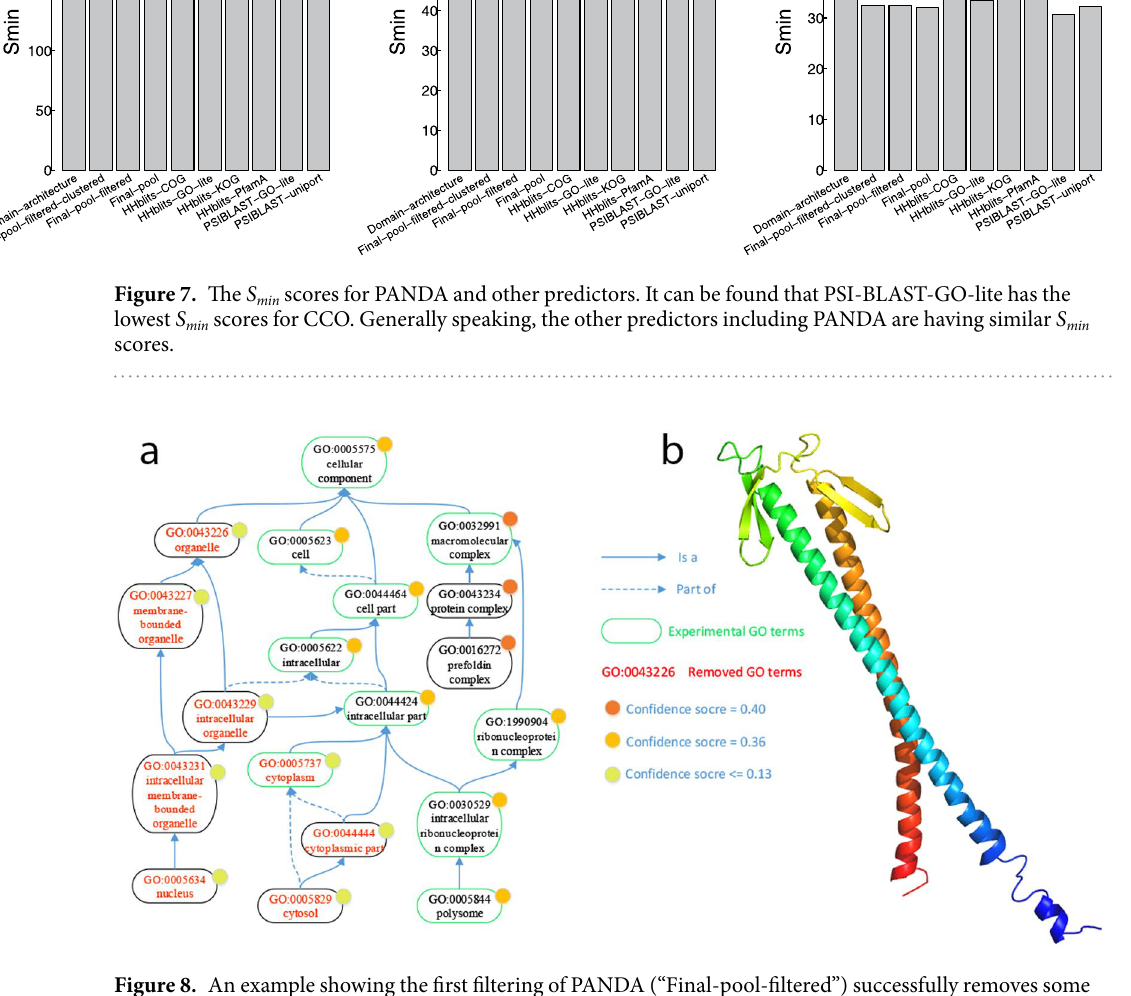
Figure 8. An example showing the first filtering of PANDA (“Final-pool-filtered”) successfully removes some low confidence wrong GO terms from pooled GO terms (“Final-pool”). ( a ) The GO directed acyclic graph showing the GO terms pooled from baseline predictors (all nodes), the GO terms with experimental evidence or the true GO terms (circled by green box), and the GO terms removed by the filtering process (in red color). This example shows that PANDA’s first Z-score based filtering successfully removes the wrongly predicted GO terms. ( b ) The predicted protein structure of the same